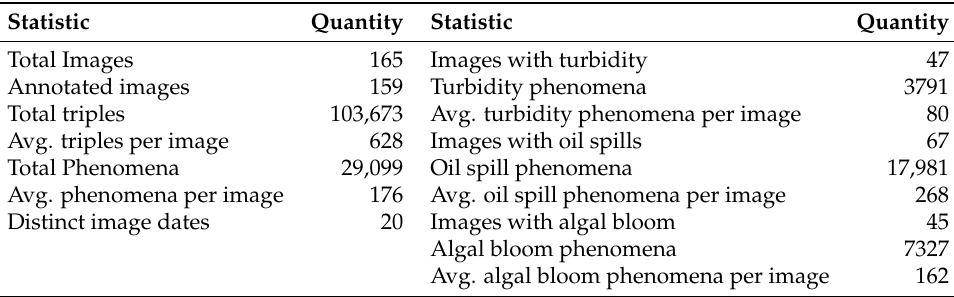
Figure 6. Geographical coverage of SeMaRe Knowledge Base images. Table 5. Knowledge base content